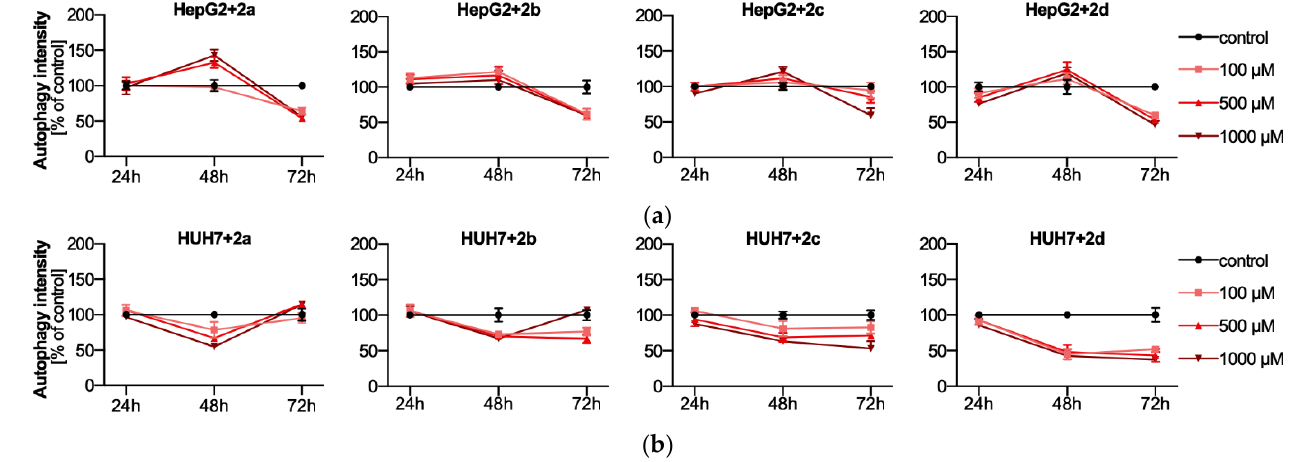
Figure 8. Autophagy induction in ( a ) HepG2 and ( b ) HUH7 cells treated with 2a – 2d at three concentrations (100, 500 and 1000 µ M) for 24 h, 48 h and 72 h. Results are presented as mean ± SD from three independent experiments, control was taken as 100%. The significance of differences was estimated based on multifactor ANOVA and post-hoc Tukey tests. HepG2+2a: p < 0.05: control vs. 100 µ M (48 h and 72 h); 100 µ M vs. 500 µ M (48 h); p < 0.01: control vs. 500 µ M (48 h); control